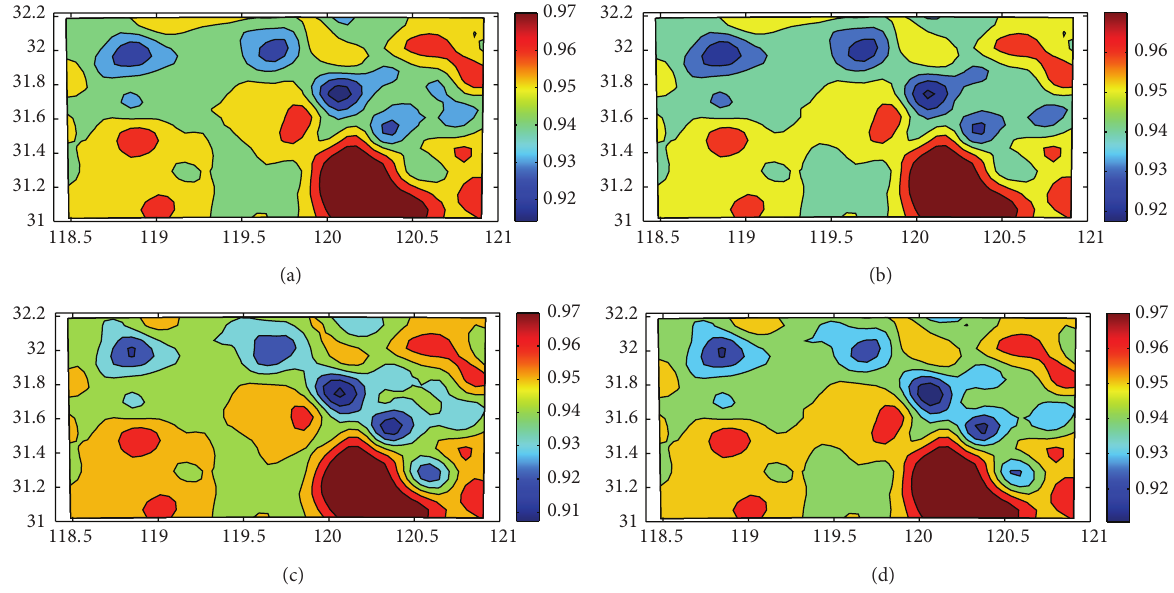
Figure 9: Spatial pattern of the land surface emissivity in Southern-Jiangsu under different scenarios. (a) and (b) show the simulation result of land surface emissivity of land use in Southern-Jiangsu in year 2010 under REG scenario and CES scenario, respectively; (c) and (d) show the simulation result of land surface emissivity of land use in Southern-Jiangsu in year 2050 under REG scenario and CES scenario, respectively.